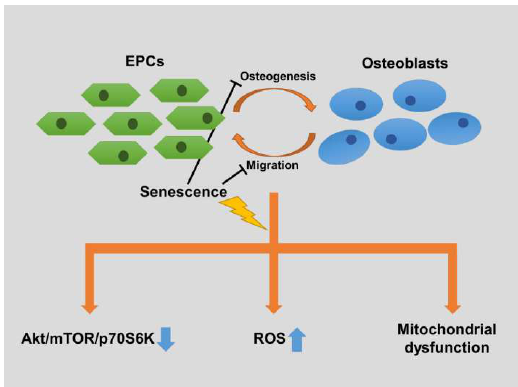
Figure 7. Schematic presentation of mechanism underling senescence-induced dysfunctions in endothelial progenitor cells and osteoblasts. Osteoblasts osteogenic activity and EPCs migratory activity both decreased in the co-culture system using senescent EPCs. Senescent EPCs decreased activation of Akt/mTOR/p70S6K signaling pathway, and elevated intracellular reactive oxygen species (ROS) and mitochondrial dysfunction (including decreased intracellular ATP and mitochondrial coupling efficiency) when co-cultured with osteoblasts.